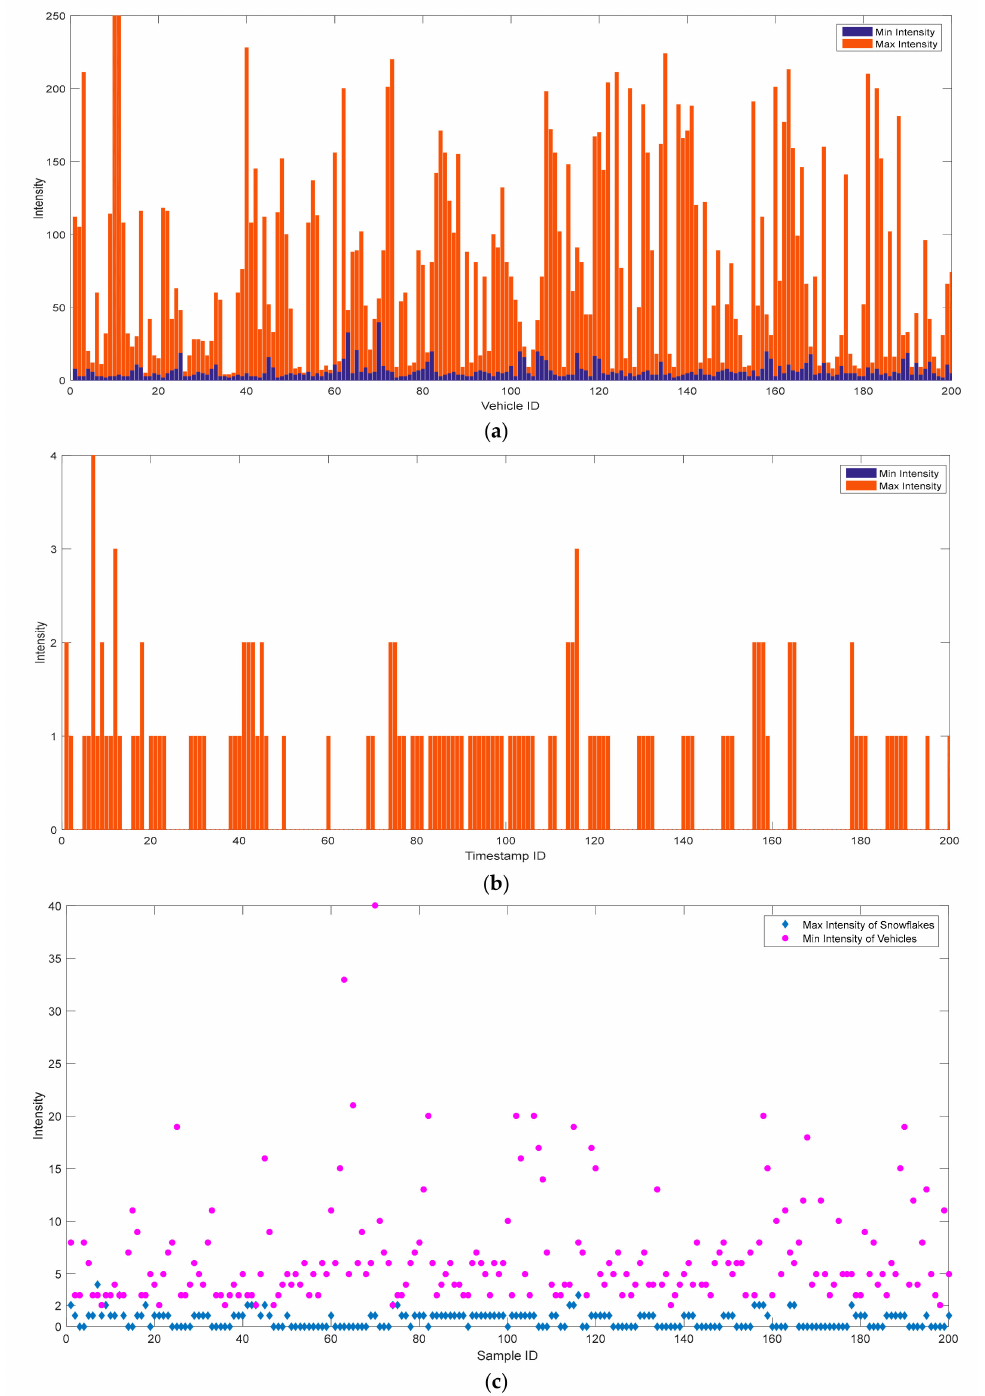
Figure 8. Intensity features of vehicles and snowflakes: ( a ) Intensity of vehicles, ( b ) Intensity of snowflakes, ( c ) Comparison of maximum intensity of snowflakes and minimum intensity of